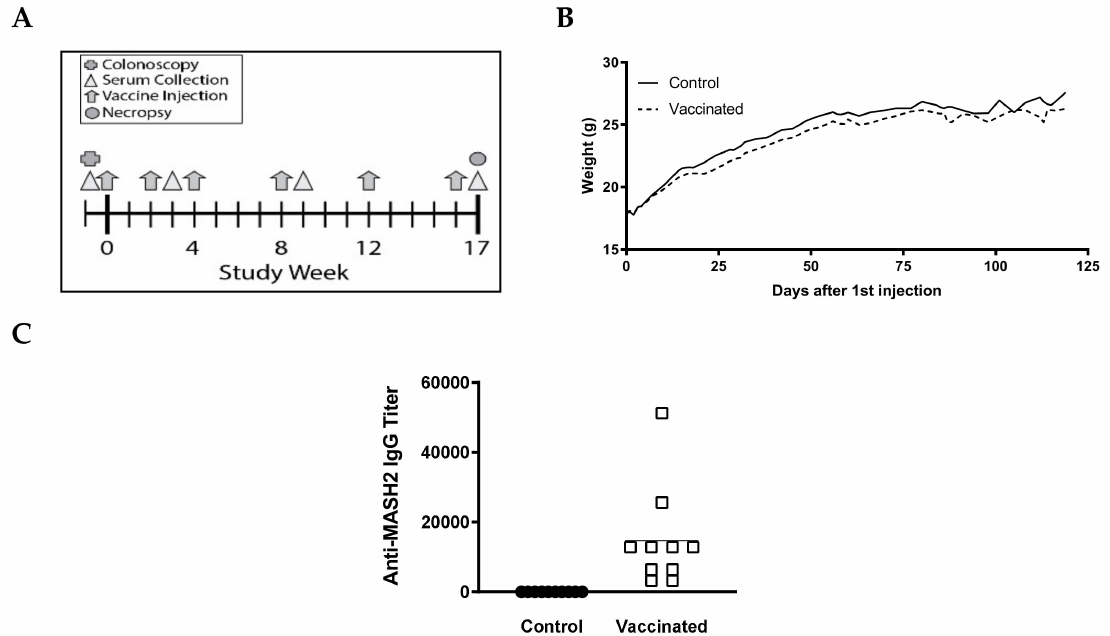
Figure 2. KISIMA-Mash2 vaccine is safe and promotes a humoral response in Apc +/Min-FCCC mice. ( A ) Study design. Apc +/Min-FCCC mice underwent colonoscopy (cross) prior to enrollment on study. Serum was collected (triangles) at 3 different time-points. Vaccine or vehicle control (arrows) was administered six times. All animals were necropsied one week after the last vaccine injection. ( B ) Average body weight of animals obtained weekly for the duration of the study. ( C ) Humoral response determined in serum at Week 17 by detecting anti-Mash2 IgG by